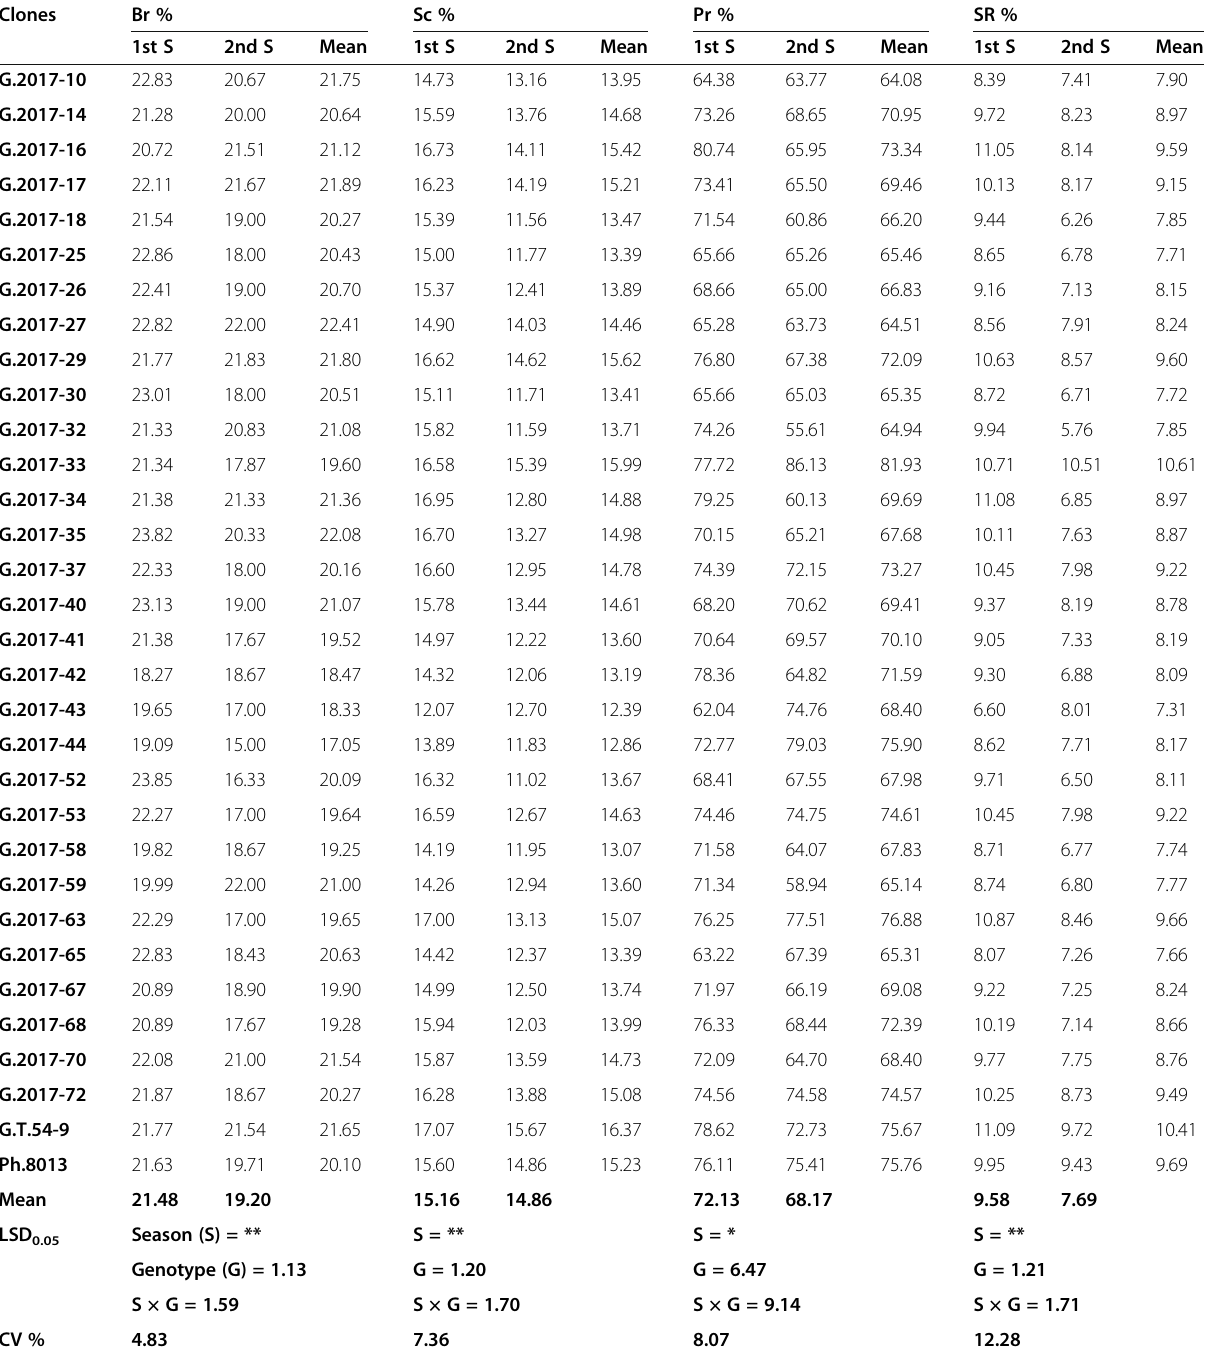
Table 4 Mean performance of 30 sugarcane genotypes and two check cultivars for quality characters in the first, second, and across the two seasons Clones Br % Sc